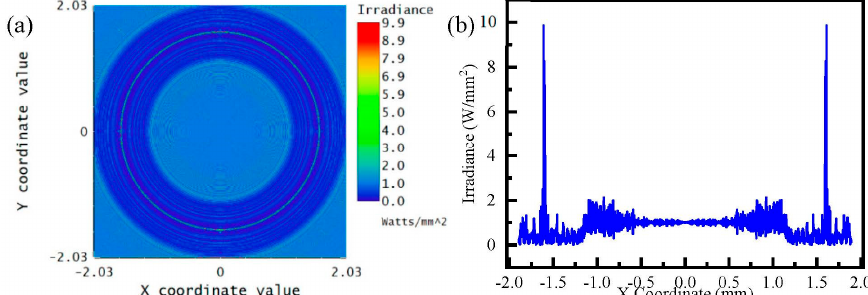
Figure 6. Simulation of AFZP with 𝑅 as 1.6 mm and 𝑟 (cid:2868) as 80 μ m: ( a ) annular beam in the focal plane; ( b ) energy distribution in the focal plane. ( b ) energy distribution in the focal